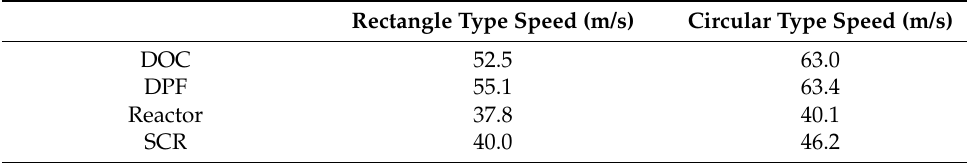
Figure 4. Velocity magnitude schematic of circle-type PM/NO X aftertreatment system. Table 3. NH 3 distribution under engine load conditions.